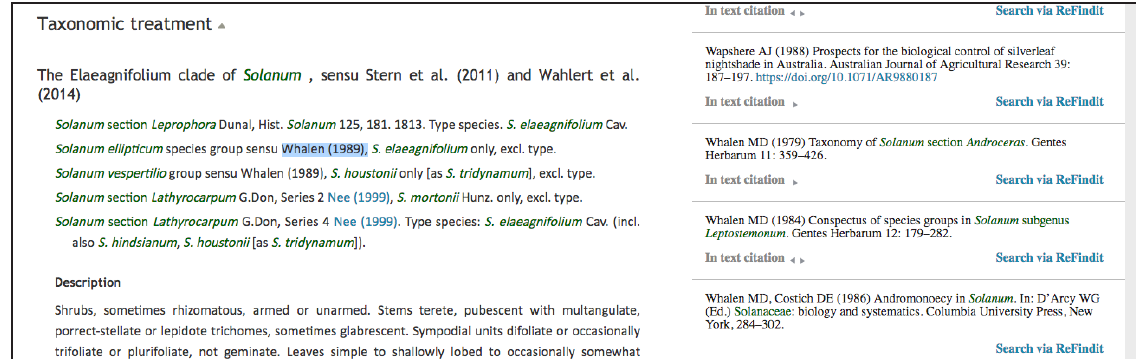
Fig. 2. Here, “Whalen (1989)” is cited in the taxonomic treatment but not listed in the references section (Knapp et al. 2017).